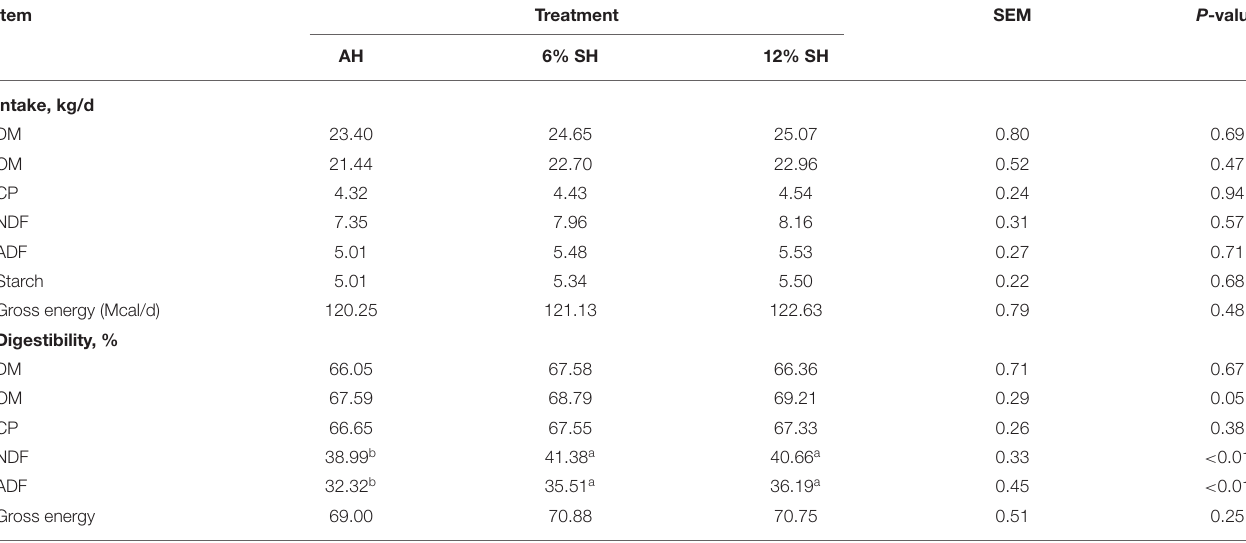
TABLE 3 | Effect of partial substitution of AH by SH on dry matter intake (DMI) and digestibility.